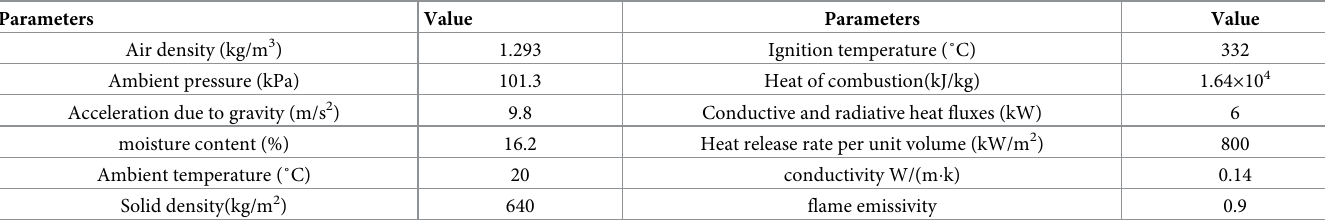
Table 1. Parameters related to combustion and flame-spreading behaviors of timber